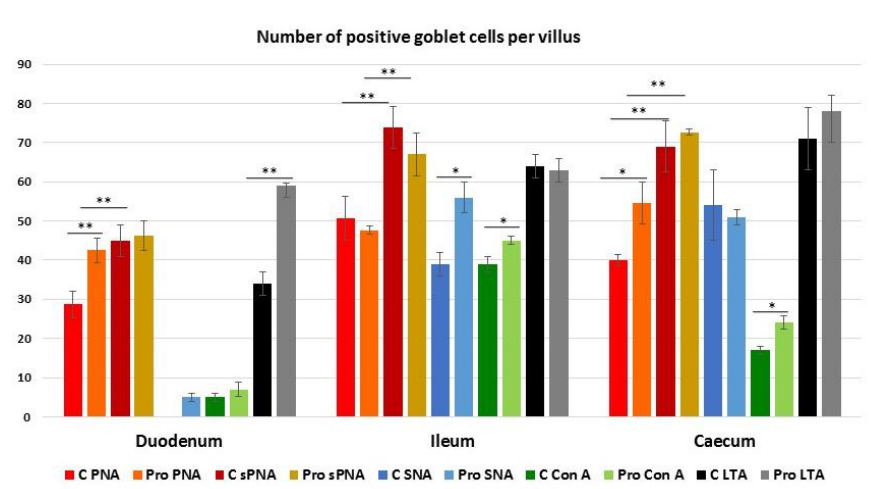
Figure 6. Number of goblet cells of C and P in guinea fowl intestine stained with Peanut agglutinin (PNA), sialidase (s)-PNA, Sambucus nigra agglutinin (SNA), Concanavalin A (Con A) and Lotus tetragonolobus agglutinin (LTA). Data show the mean with error bars representing ± SE and Student’s t -test results: * p < 0.05; ** p < 0.001.